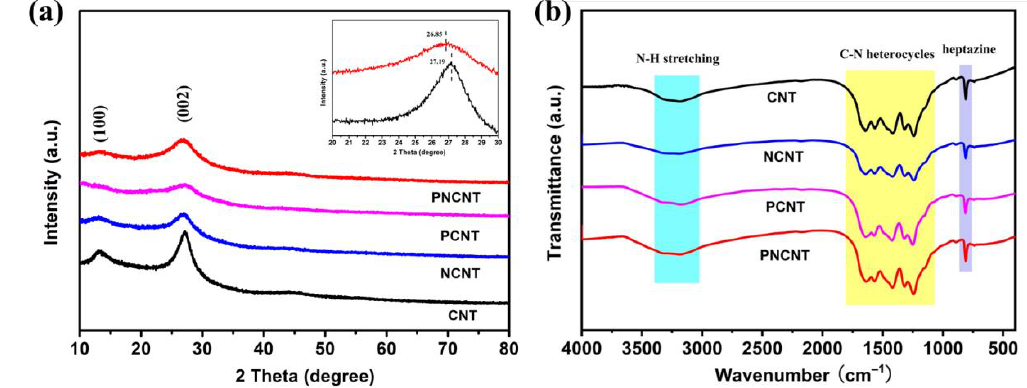
Figure 4. XRD pattern ( a ) and FTIR spectra ( b ) of CNT, NCNT, PCNT and PNCNT samples.